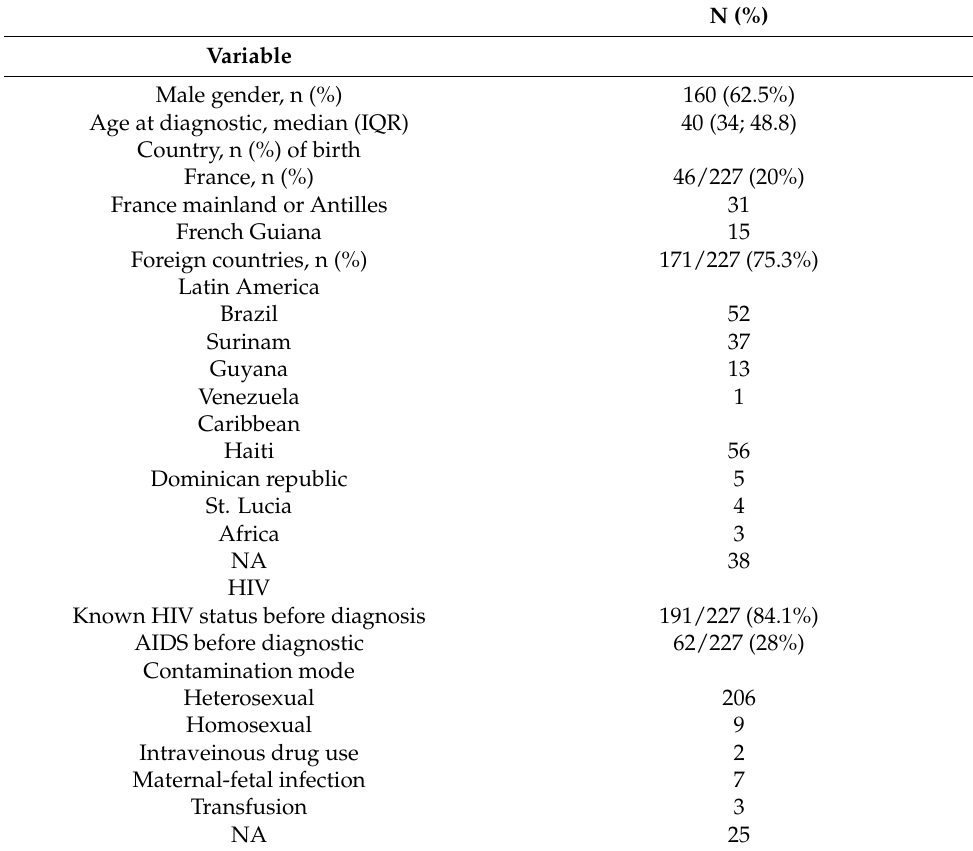
Table 1. Populations